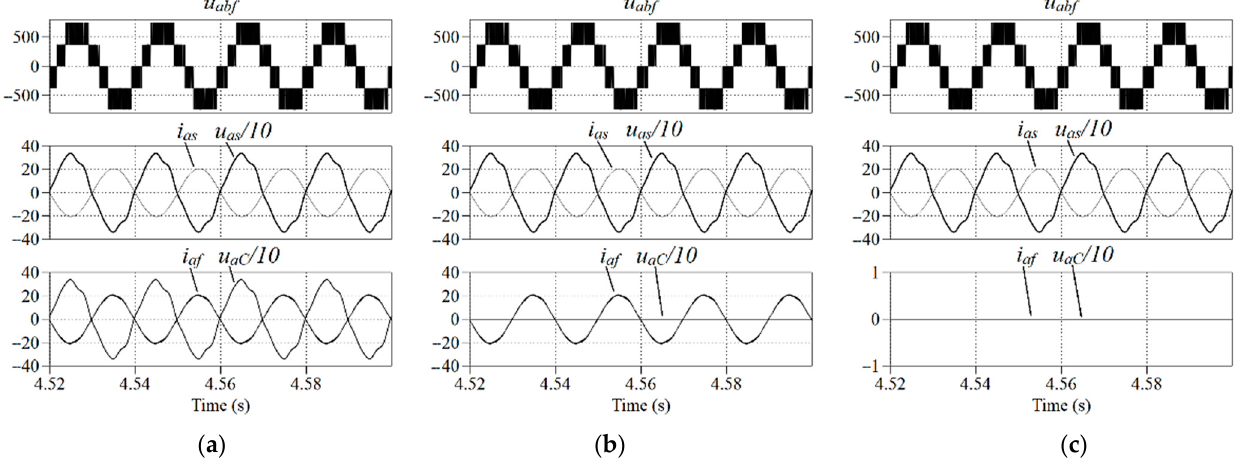
Figure 20. Voltage waveforms u abf and current i af of the inverter, u abs voltage and current i as of the power grid, and u aC capacitor voltage in steady state ( a ) with all measurements, ( b ) without measuring the capacitor voltage, ( c ) without measuring the inverter current and capacitor voltage.